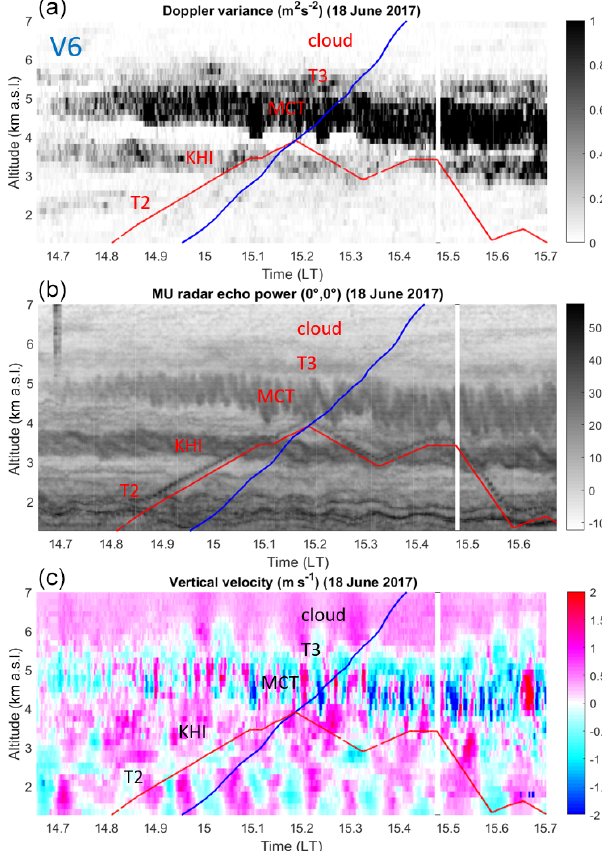
Figure 4. Same as Fig. 2 for SH14 and